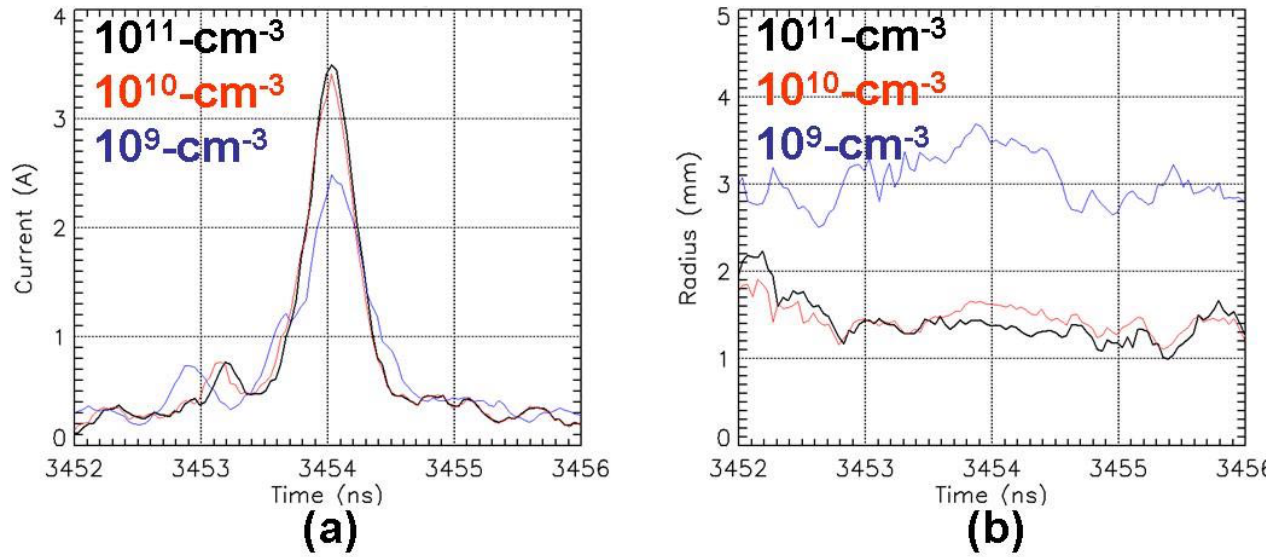
FIG. 5. (Color) In a series of kinetic plasma simulations, the (a) compressed beam current and (b) edge radius at simultaneous compression are shown for the three plasma densities as a function of time.